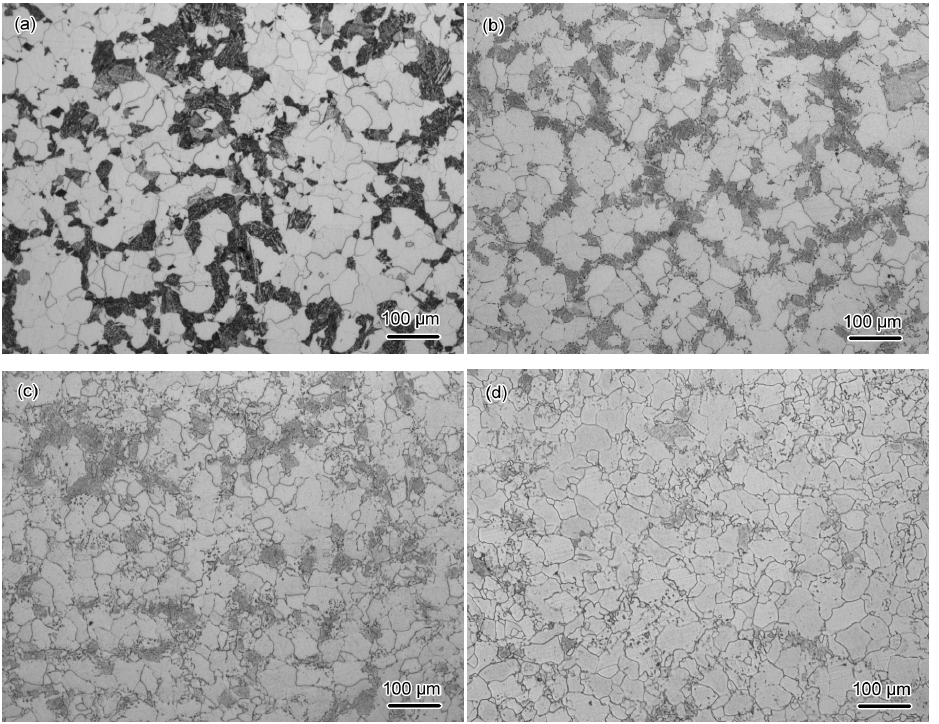
Figure 2. Metallographic photographs of the microstructure of G18CrMo2–6 steel tempered at 680 °C for different times: ( a ) 0 h, ( b ) 100 h, ( c ) 500 h, ( d ) 1000 h.